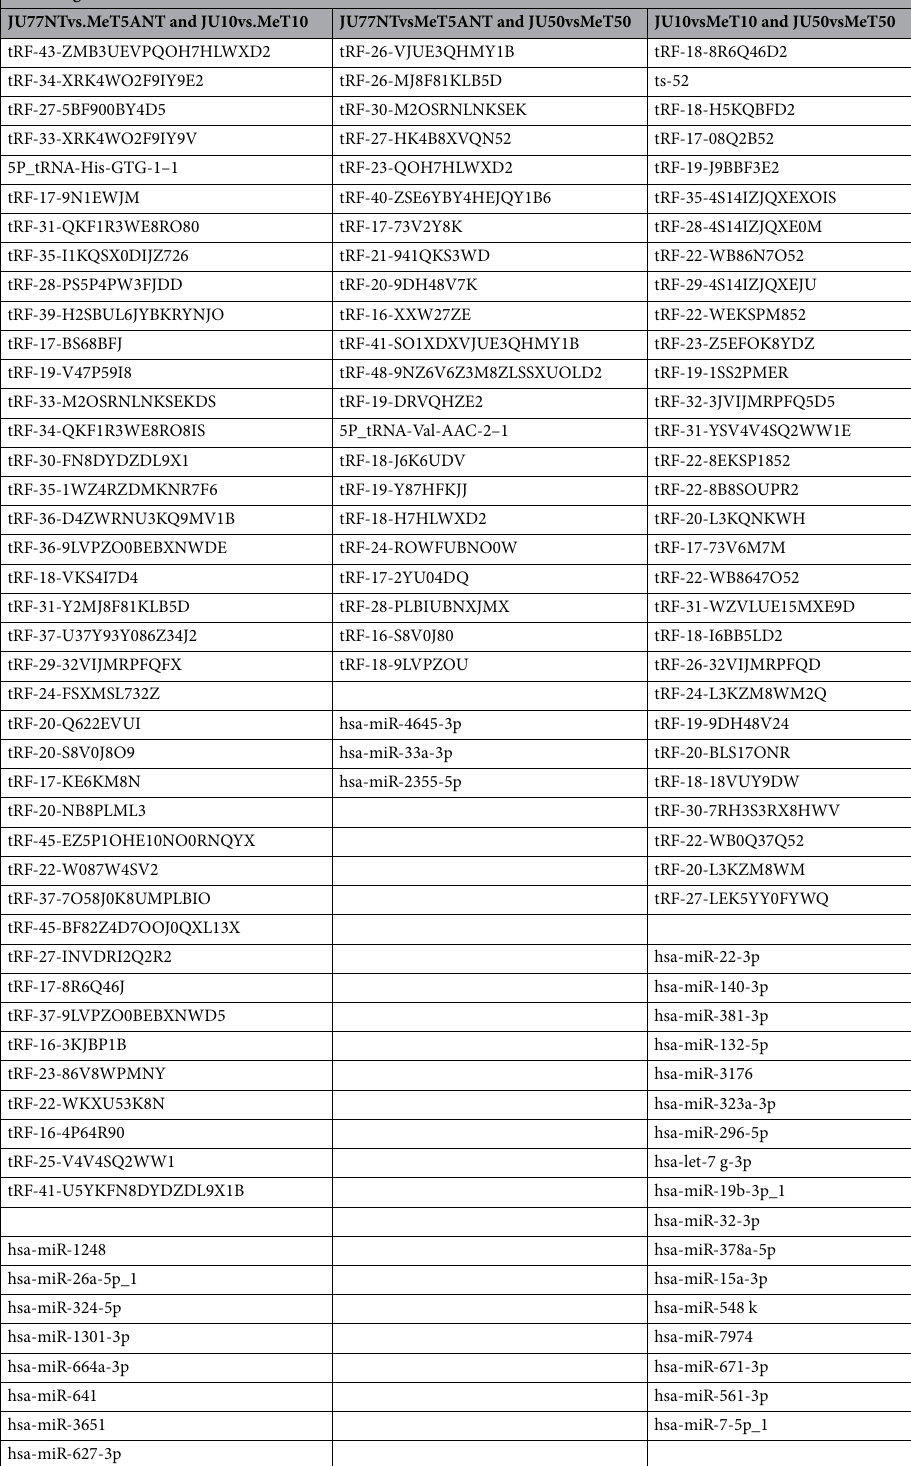
Table 2. Down-regulated ncRNAs in common among JU77 (human malignant mesothelioma) vs. MeT-5A (human normal mesothelium) controls and JU77 vs. exposed to 10 and 50 ug/ml FE fibers; down-regulated ncRNAs in common among JU77 vs. MeT-5A exposed to 10 and exposed to 50 ug/ml FE